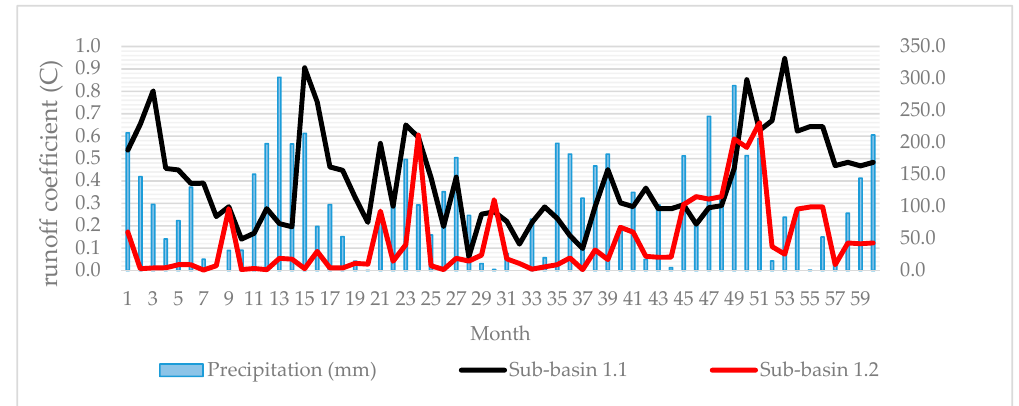
Figure 10. Precipitation (mm) and sub-basin 1.1 and 1.2 runoff coefficient (C) from January 2012 (Month 1) to December 2016 (month 60) in the Olaria stream watershed.